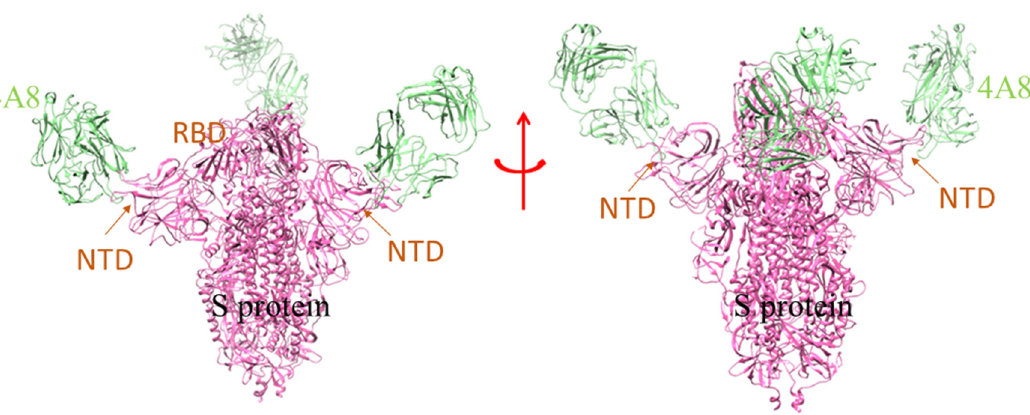
Figure 3. The model demonstrates the binding of human mAb (4A8) to the NTD of S ‐ protein of SARS ‐ CoV ‐ 2 [PDB id: 7C2L]. The chains of the mAb unit interact with the different NTD of the S ‐ protein trimeric sub ‐ unit domain.